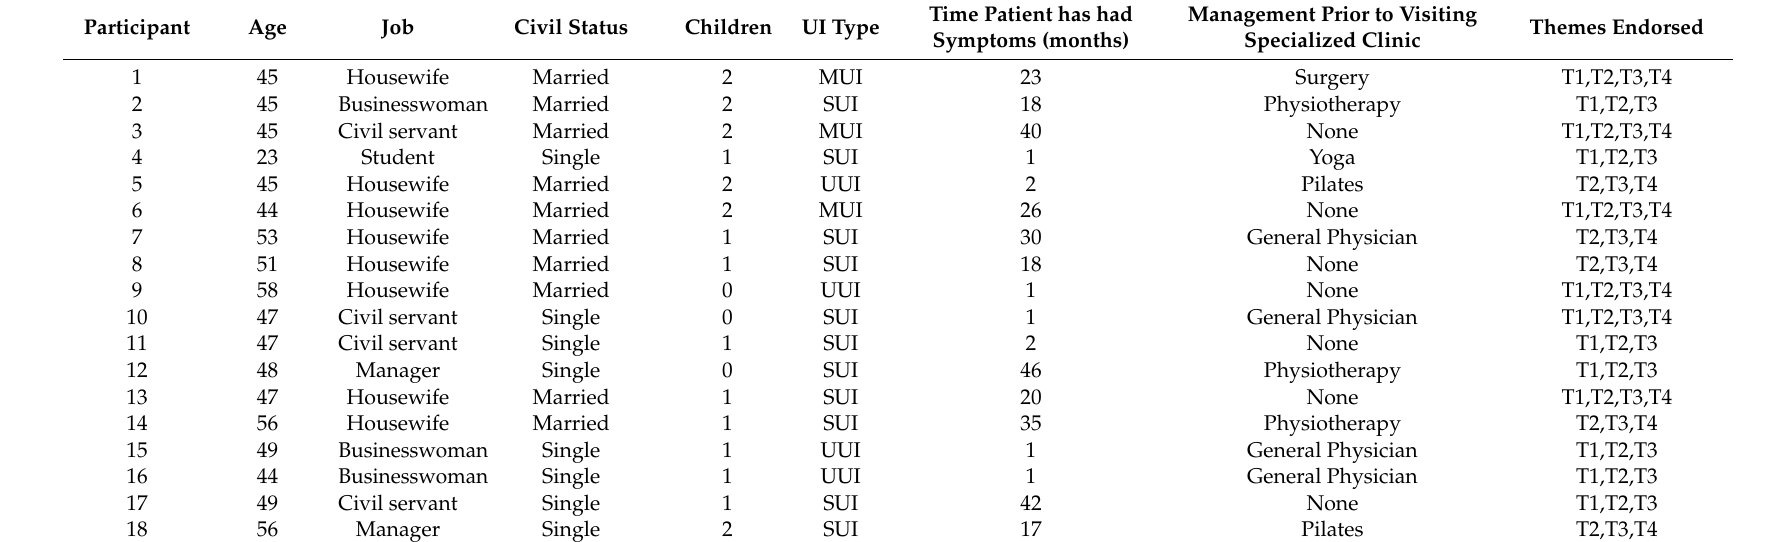
Table 2. Participant demographic